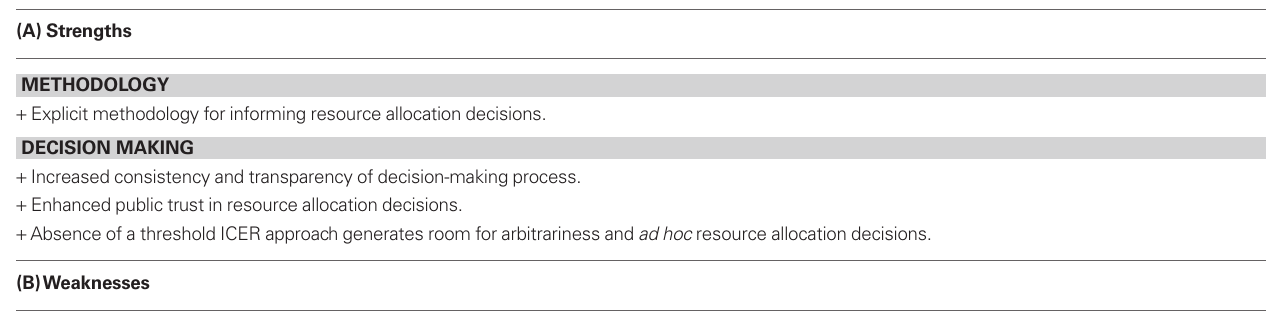
Table 1 | Strengths and weaknesses of the threshold iCer